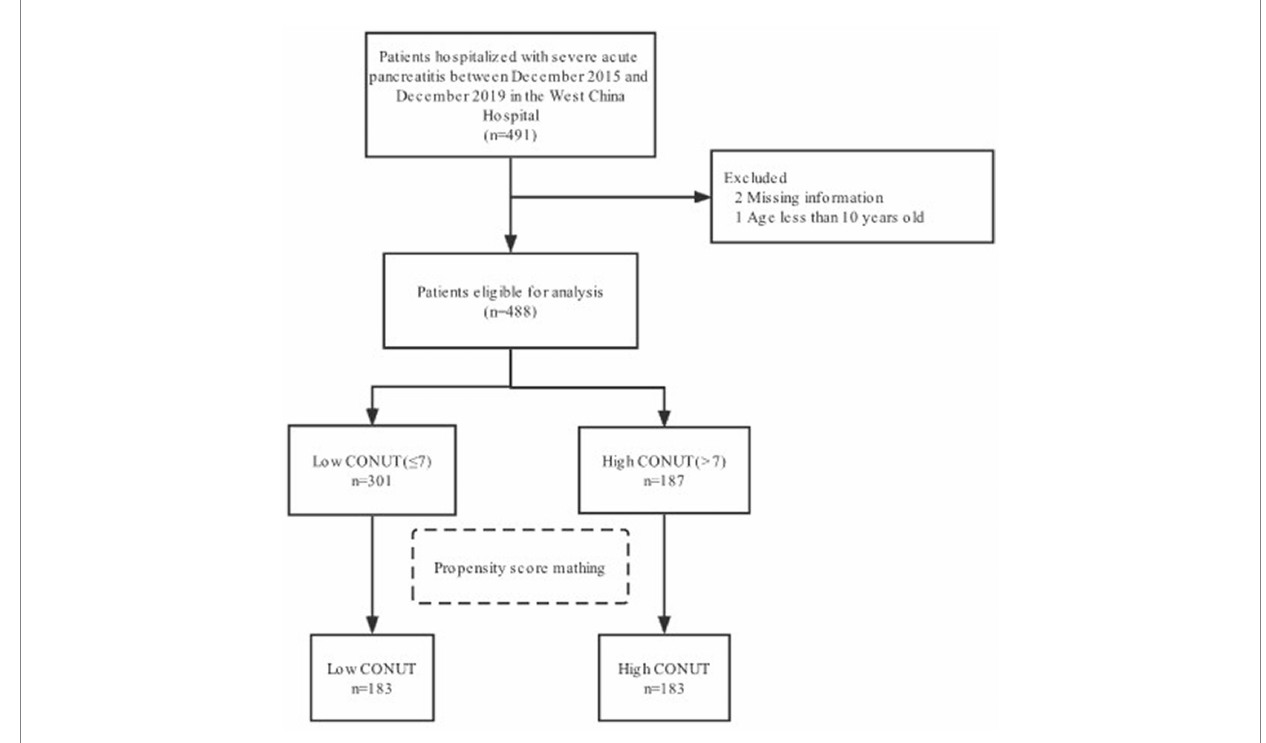
FIGURE 1 The inclusion of the study